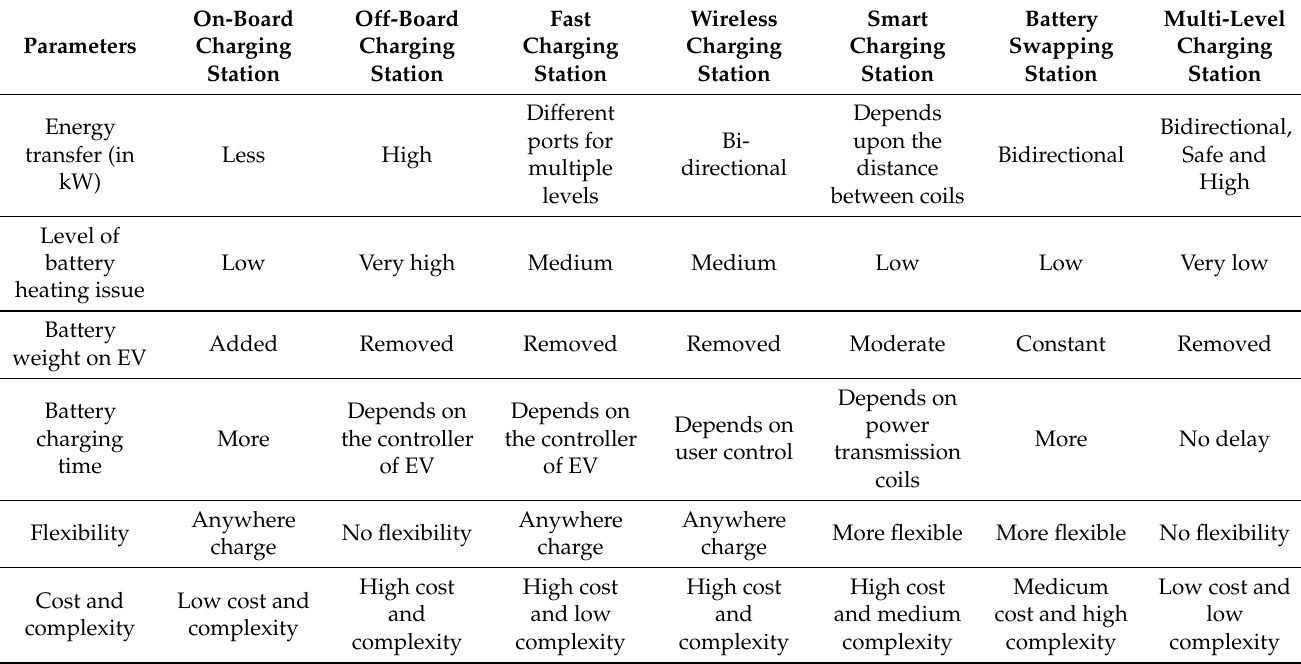
Table 2. Comparison of Charging